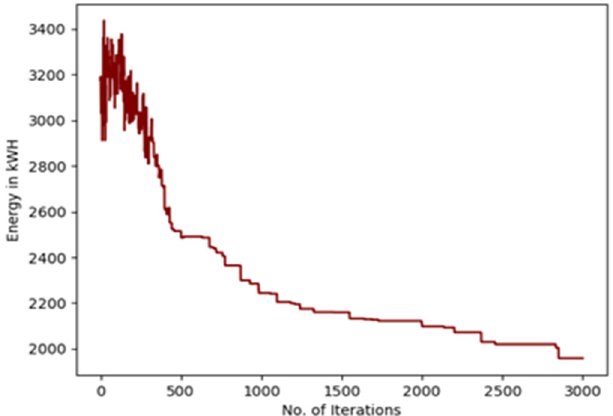
Figure 5. Total energy consumed by the three trucks (SA).